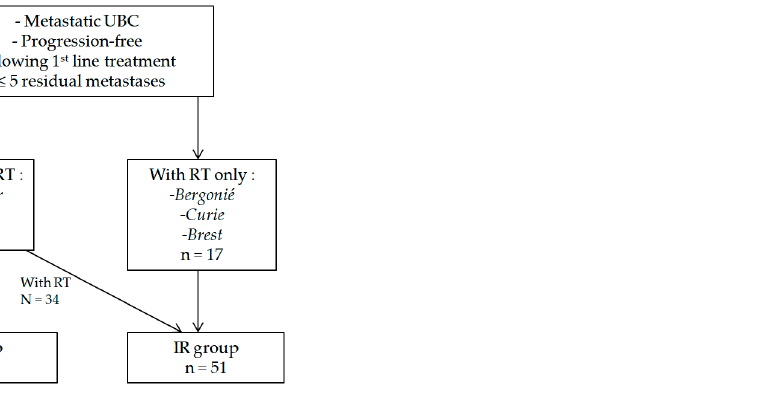
Figure 1. Flow diagram for the selection of patients. Abbreviations: UBC: urothelial bladder cancer; RT: radiotherapy; NIR group: no irradiation group; IR group: irradiation group.